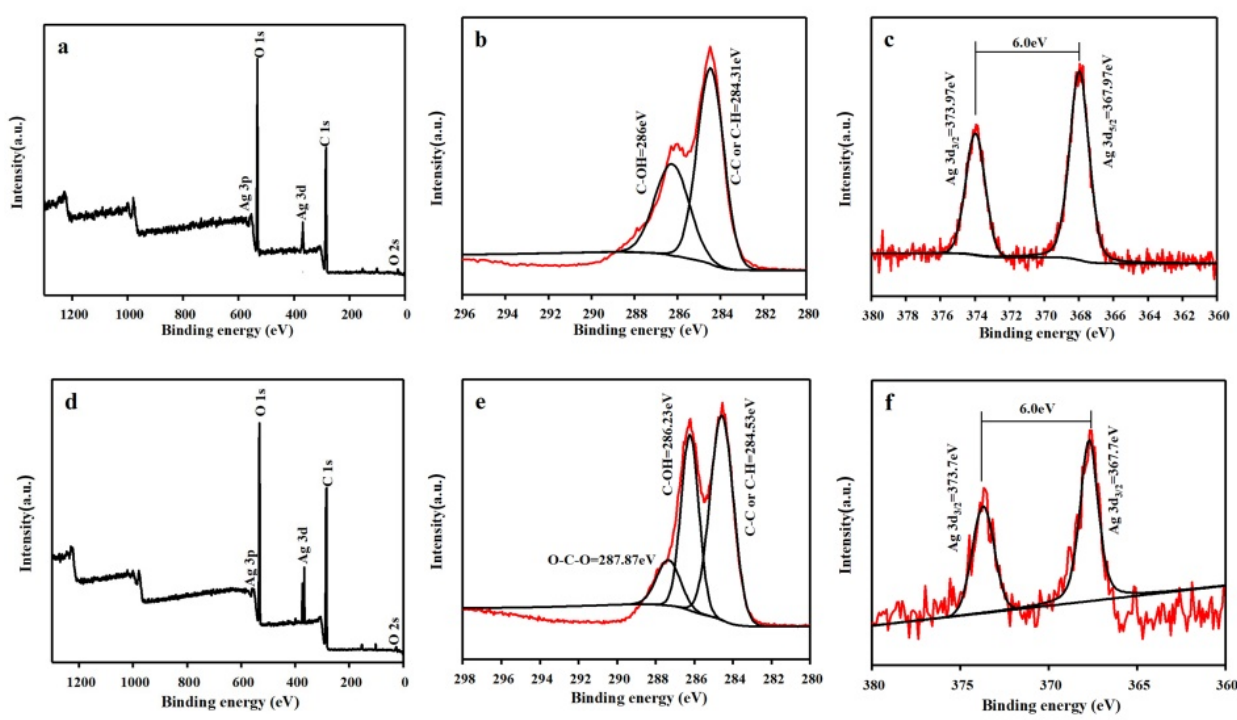
Figure 9. XPS spectra of Ag/Cotton ( a – c ) and PMA-CA-Ag/cotton ( d – f ).